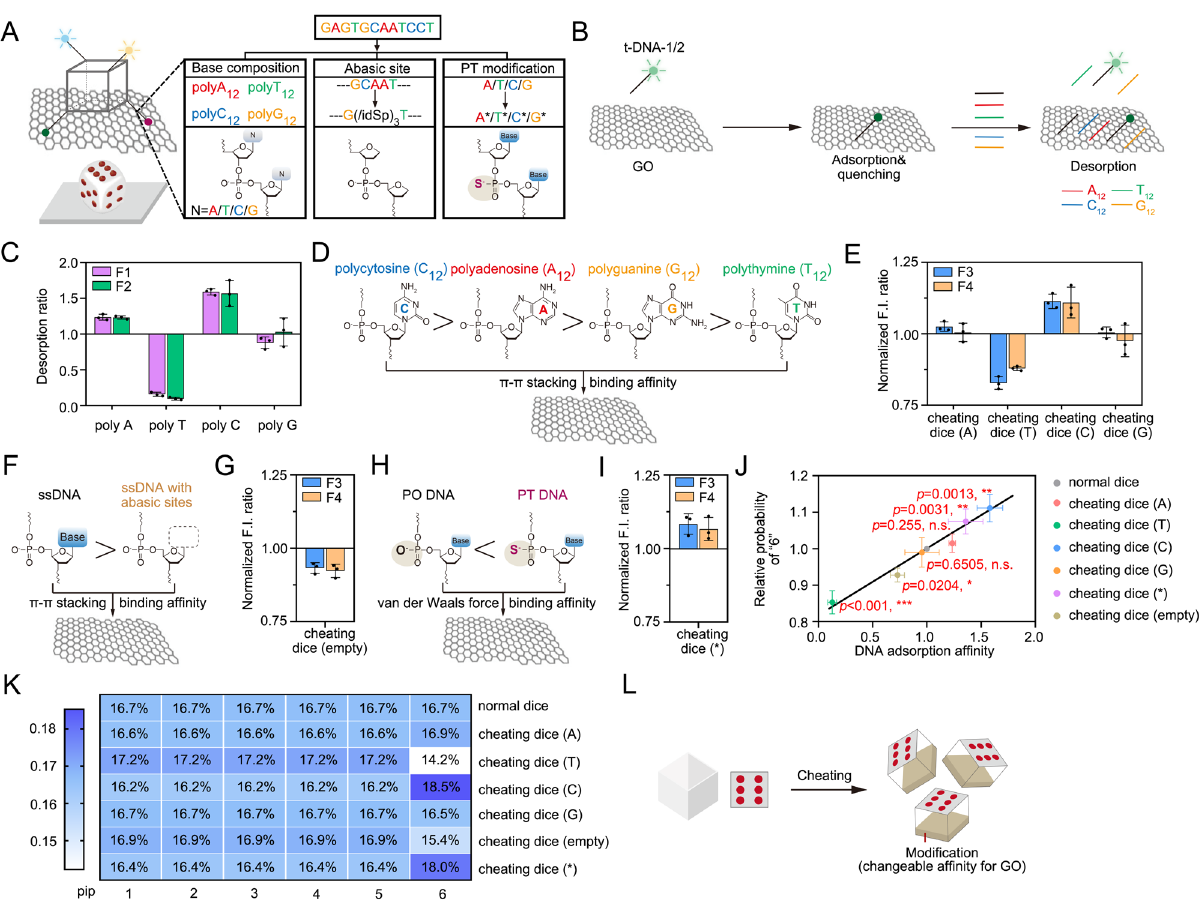
Fig.7|ThecheatingbehaviorofDNAnano-dicesystem.A Schematicillustration of three cheating methods for nano-dice. PT modi fi cation: phosphorothioate modi fi cation. B Schematic illustration of adsorption and desorption of original t- DNA-1/2 by adding poly A 12 /T 12 /C 12 /G 12 . C Desorption ratio of FAM labeled original DNA (group 1) from GO by poly A 12 /T 12 /C 12 /G 12 after 60min reaction, n =3 inde- pendent experiments. Data are presented as mean values±s.d. D Schematic illus- tration of the differences of the binding af fi nity between polyN 12 (N=A, T, C or G) and GO. E Normalized fl uorescenceintensityratioof cheating dice (A/T/C/G), n =3 independent experiments. Data are presented as mean values±s.d. F Schematic illustrationofthedifferencesbetweennormalt-DNAandt-DNAwithabasicsiteson GO. G Normalized fl uorescence intensity ratio of cheating dice (empty), n =3 independent experiments. Data are presented as mean values±s.d. H Schematic illustration of the differences between PO DNA and PT DNA on GO. PO DNA: DNA withphosphodiesterbackbone;PTDNA:DNAwithphosphorothioatemodi fi cation.